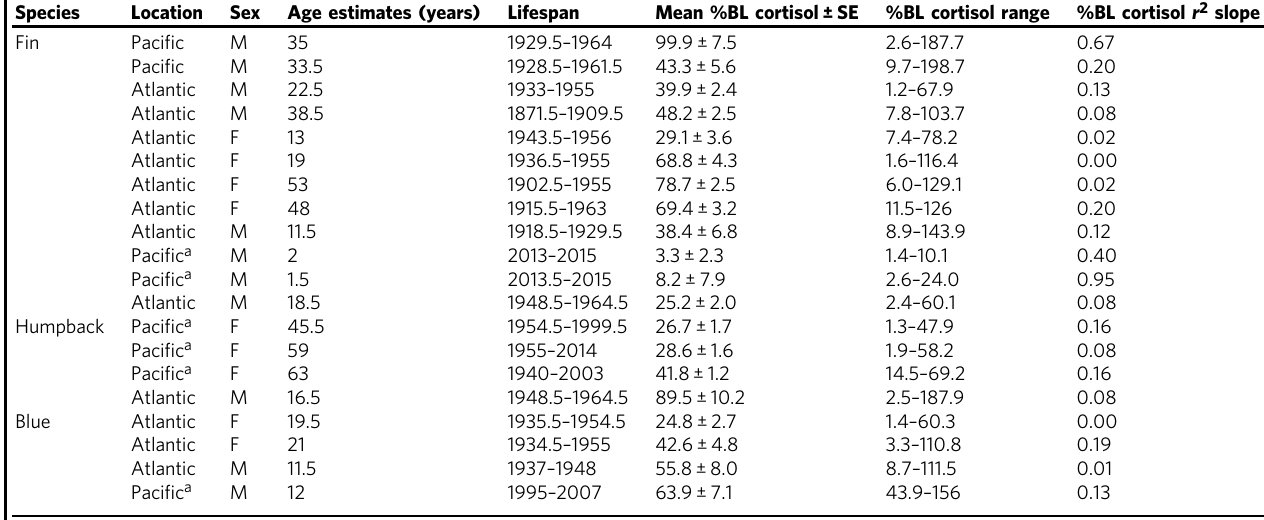
Table 3 Mean cortisol as a percent change from baseline (baseline-corrected) and standard error (± SE) for fi n, humpback, and blue whales in the N. Hemisphere as related to location (ocean basin), sex, estimated age (years), and life span